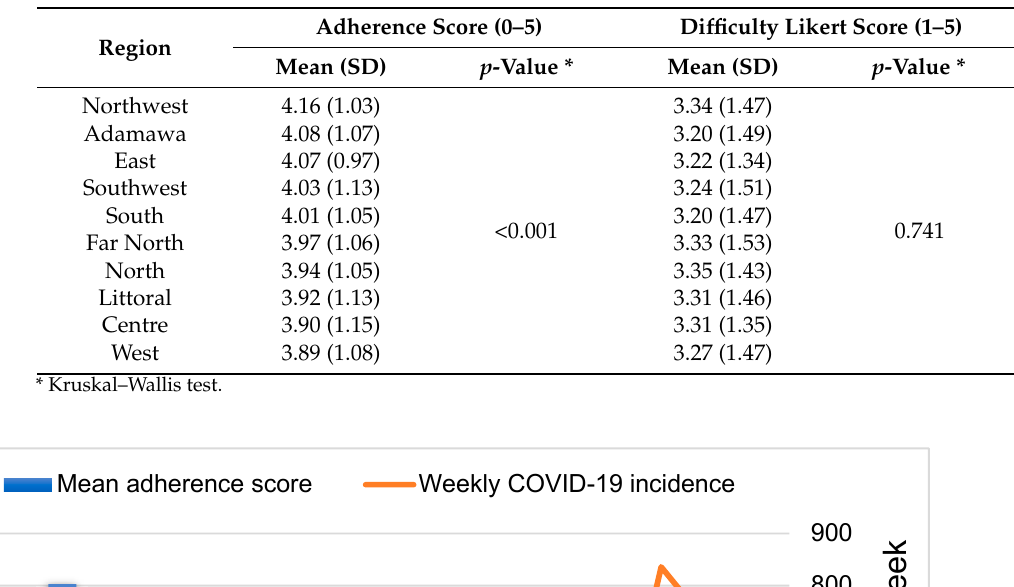
Table 3. Adherence and difficulty scores by region.